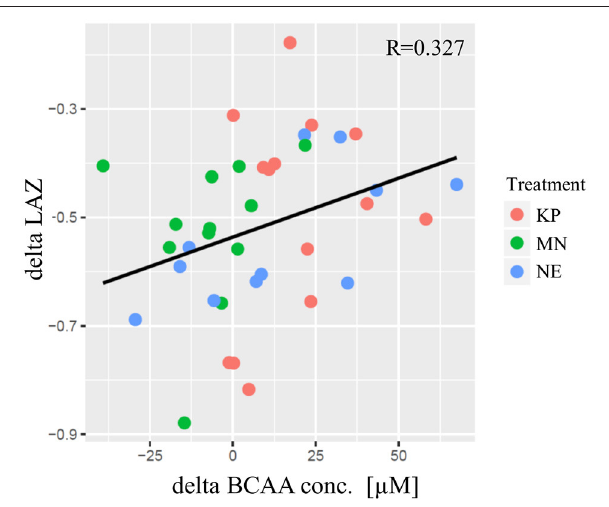
FIGURE 2 | The correlation between delta LAZ and delta plasma BCAA concentration. The horizontal axis indicates the delta of plasma BCAA concentration [ µ M] from baseline to end point. The vertical axis indicates the delta of LAZ from baseline to end point. Each plot indicate community average. KP, MN, and NE are shown in red, green and blue, respectively. The regression line was shown in black and pearson’s correlation was significant ( R = 0.327; p = 0.048). KP, KOKO Plus; MN, Micronutrient; NE, Nutrition Education; BCAA, Branch chain amino acid; LAZ, Length for age z-score.